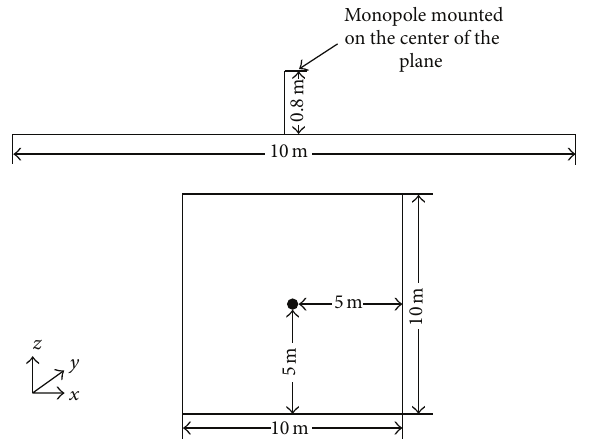
Figure 2: A monopole mounted on an electrically large plane.